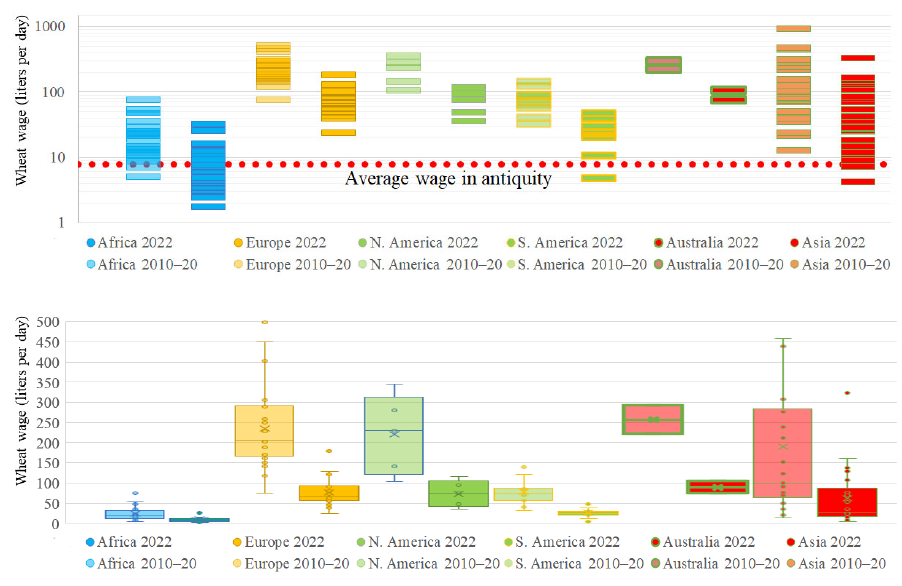
Figure 7. Average wages in different countries (data from [108]) converted to wheat wages. 2016: wheat price average of 2010–2020 was about 210 € per ton; 2022: wheat price was about 650 € per ton. Data accuracy is low as prices depend on local markets. Top: plot in logarithmic scale indicating the average wage in antiquity (e.g., what we used to consider as extreme poverty); bottom: box plot.